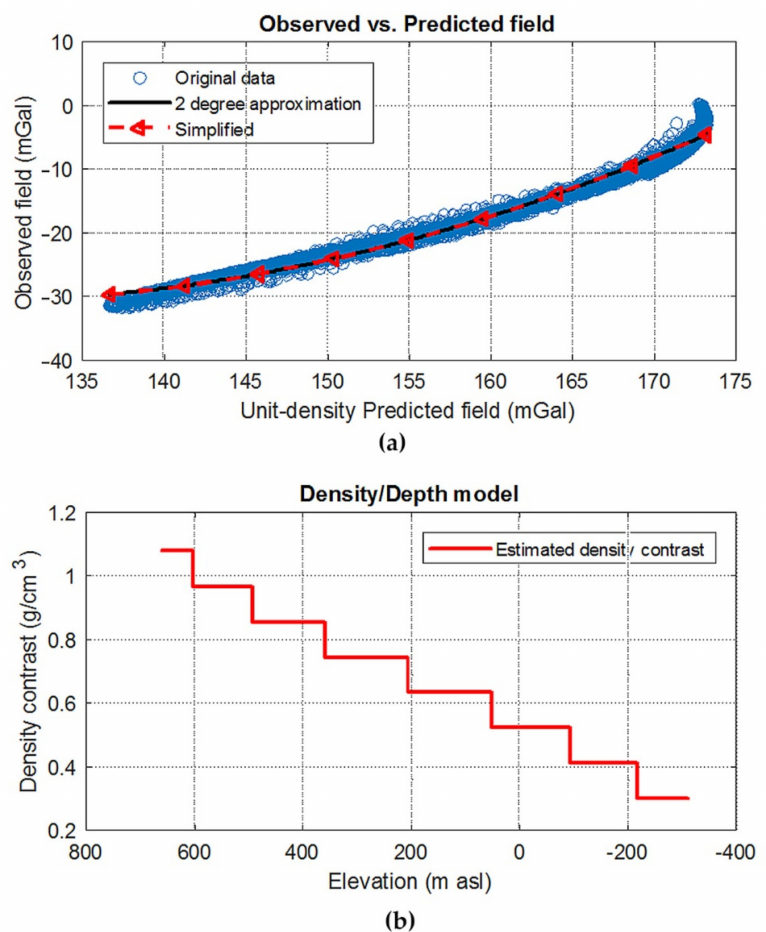
Figure 5. Estimation of the depth-density function for the Fucino basin. ( a ) Unit-density gravity field generated by the first-approximation model vs. the residual gravity data. The points cloud is approximated using a second-degree polynomial and simplified in a set of 8 linear segments using the Douglas and Peucker (1973) method [42]. ( b ) The depth-density function estimated by using the slope of each segment in a) and the observed gravity relative to their endpoints following the procedure [12]. In this plot, an average elevation of 677 m asl is considered for the Fucino